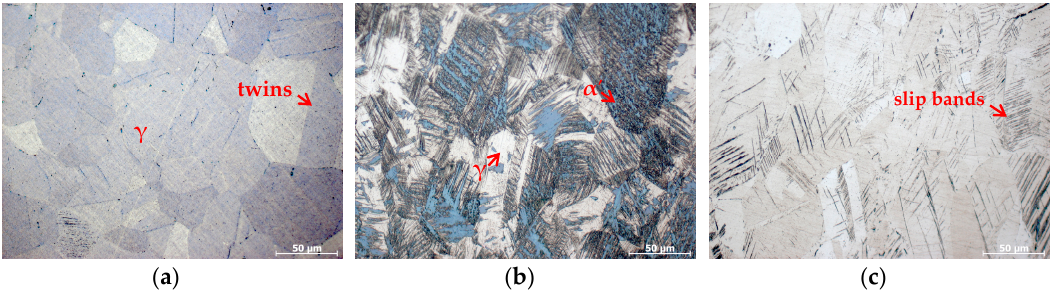
Figure 1. Microstructures of specimens: ( a ) Un-pre-strained; ( b ) 30% pre-strained at 20 °C; ( c ) 30% pre-strained at 80 °C.